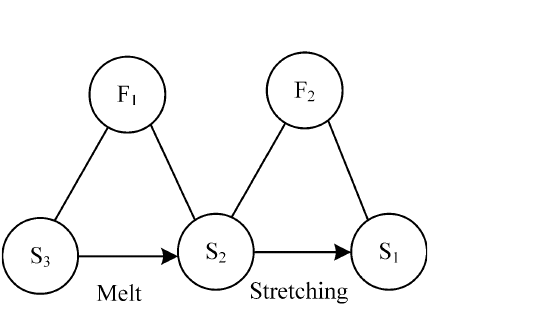
Figure 3. Schematic diagram of MMS device.